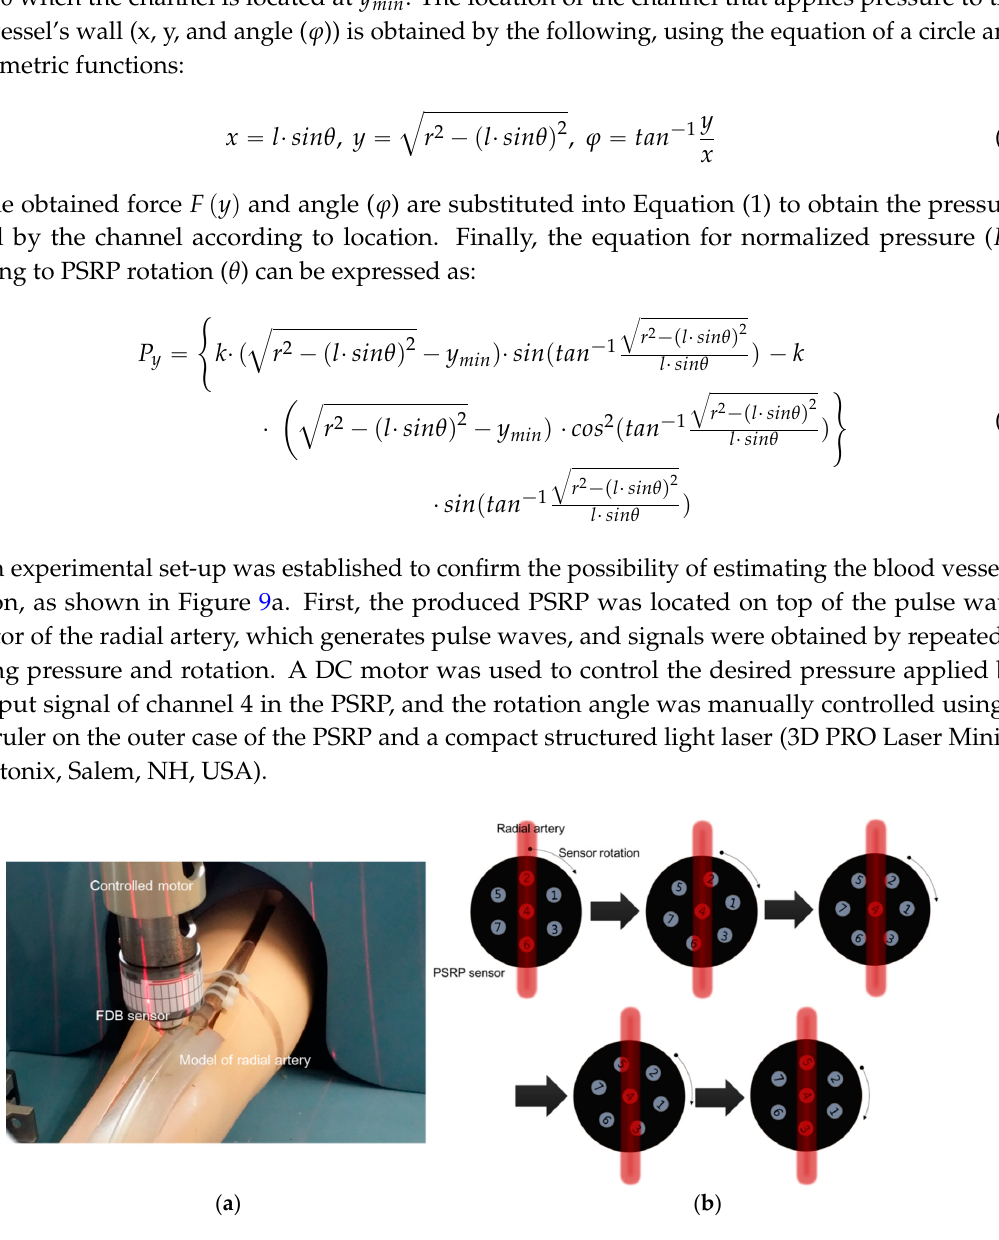
Figure 9. ( a ) Experimental set-up and ( b ) experimental sequence for estimating blood vessel direction.